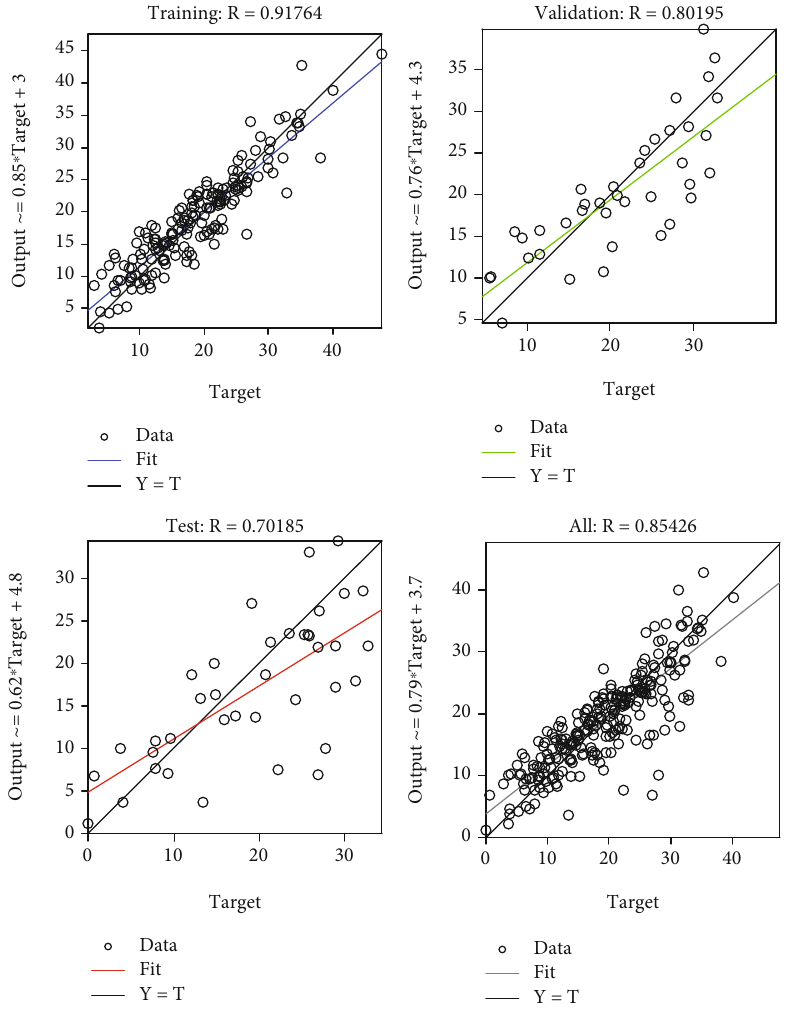
Figure 4: Fitness of proposed method during MPPT at all